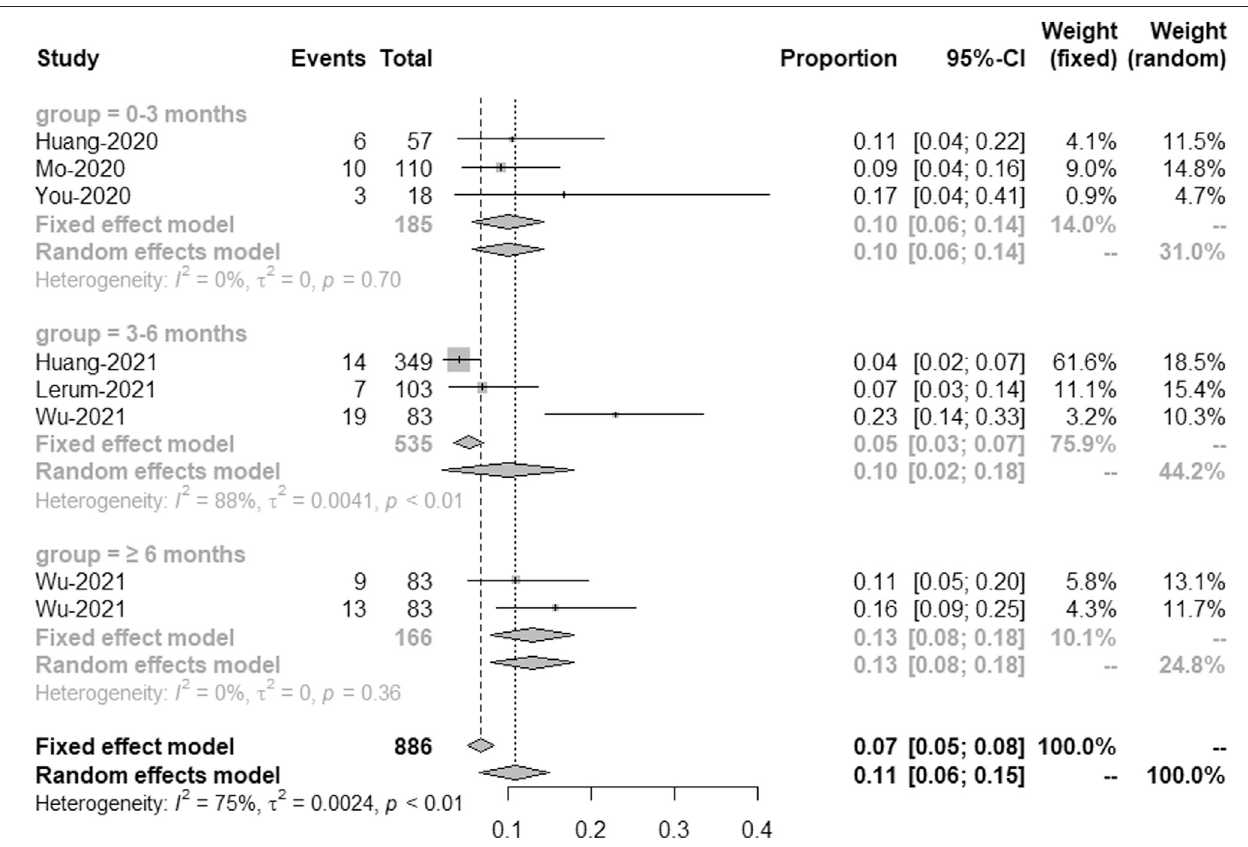
FIGURE5| Comparisonoflongitudinalchangesinthepercentage ofpatientswithFVC < 80%ofpredicted.Forestplotshowingmeta-analysisofthepercentageof patients with FVC < 80% of predicted.